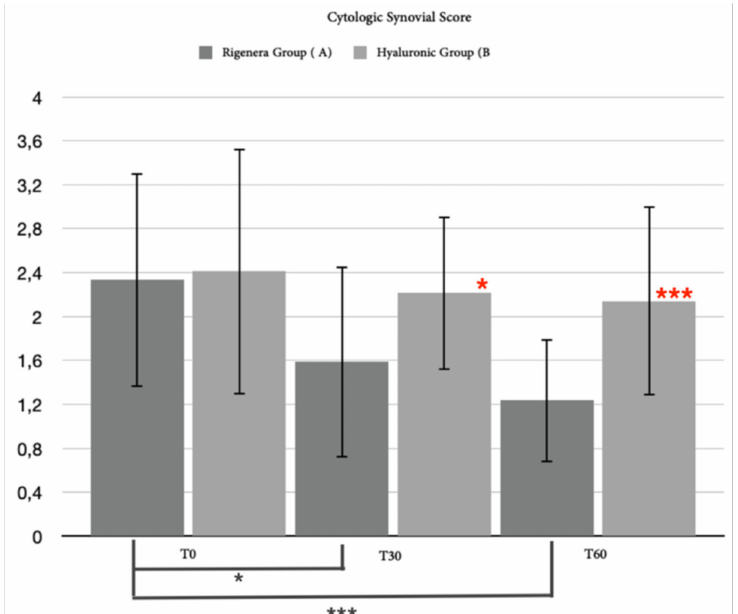
Figure 9. This graph shows the differences in statistical analysis data between hyaluronic group and MFAT group for the cytological synovial score after 30 days and after 60 days. Red asterisks (*: p = 0.0331; ***: p = 0.008) indicate significant differences between groups, and group-colored asterisks indicate significant differences within each group (*: p = 0.0258; ***: p =